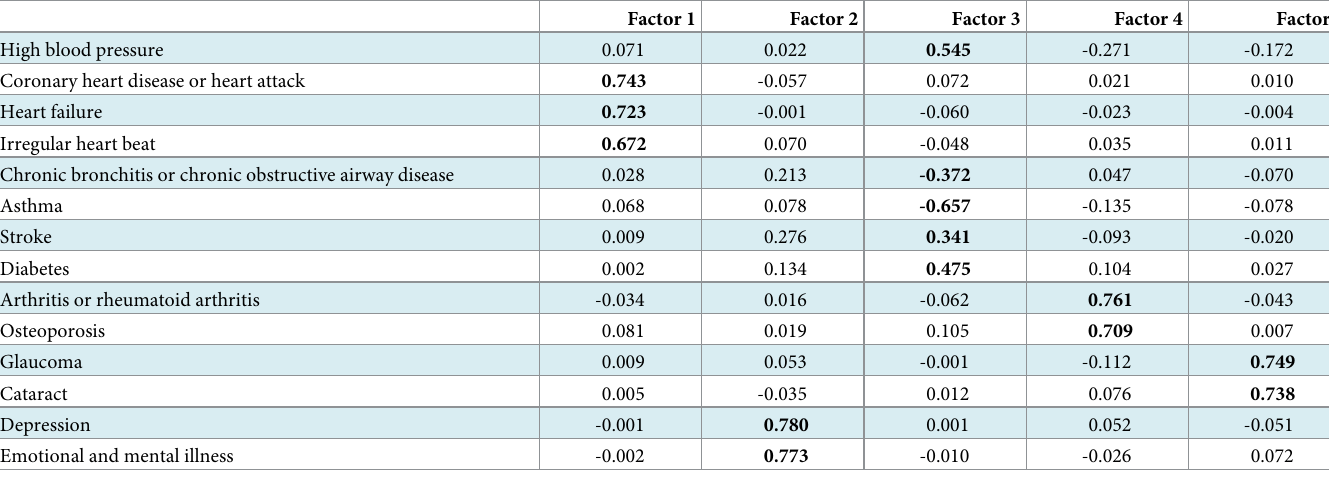
Table 4. Loadings for the five-factor solution following an exploratory factor analysis based on tetrachoric correlation